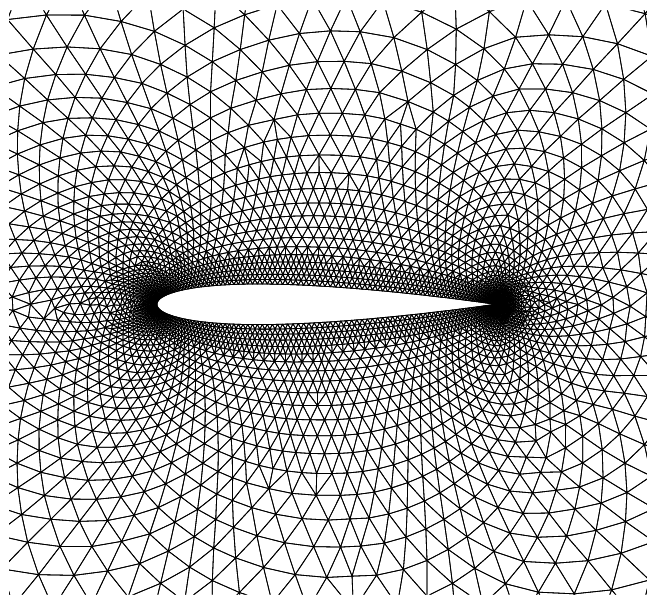
Figure 4. Close-up of the baseline NACA0012 mesh.